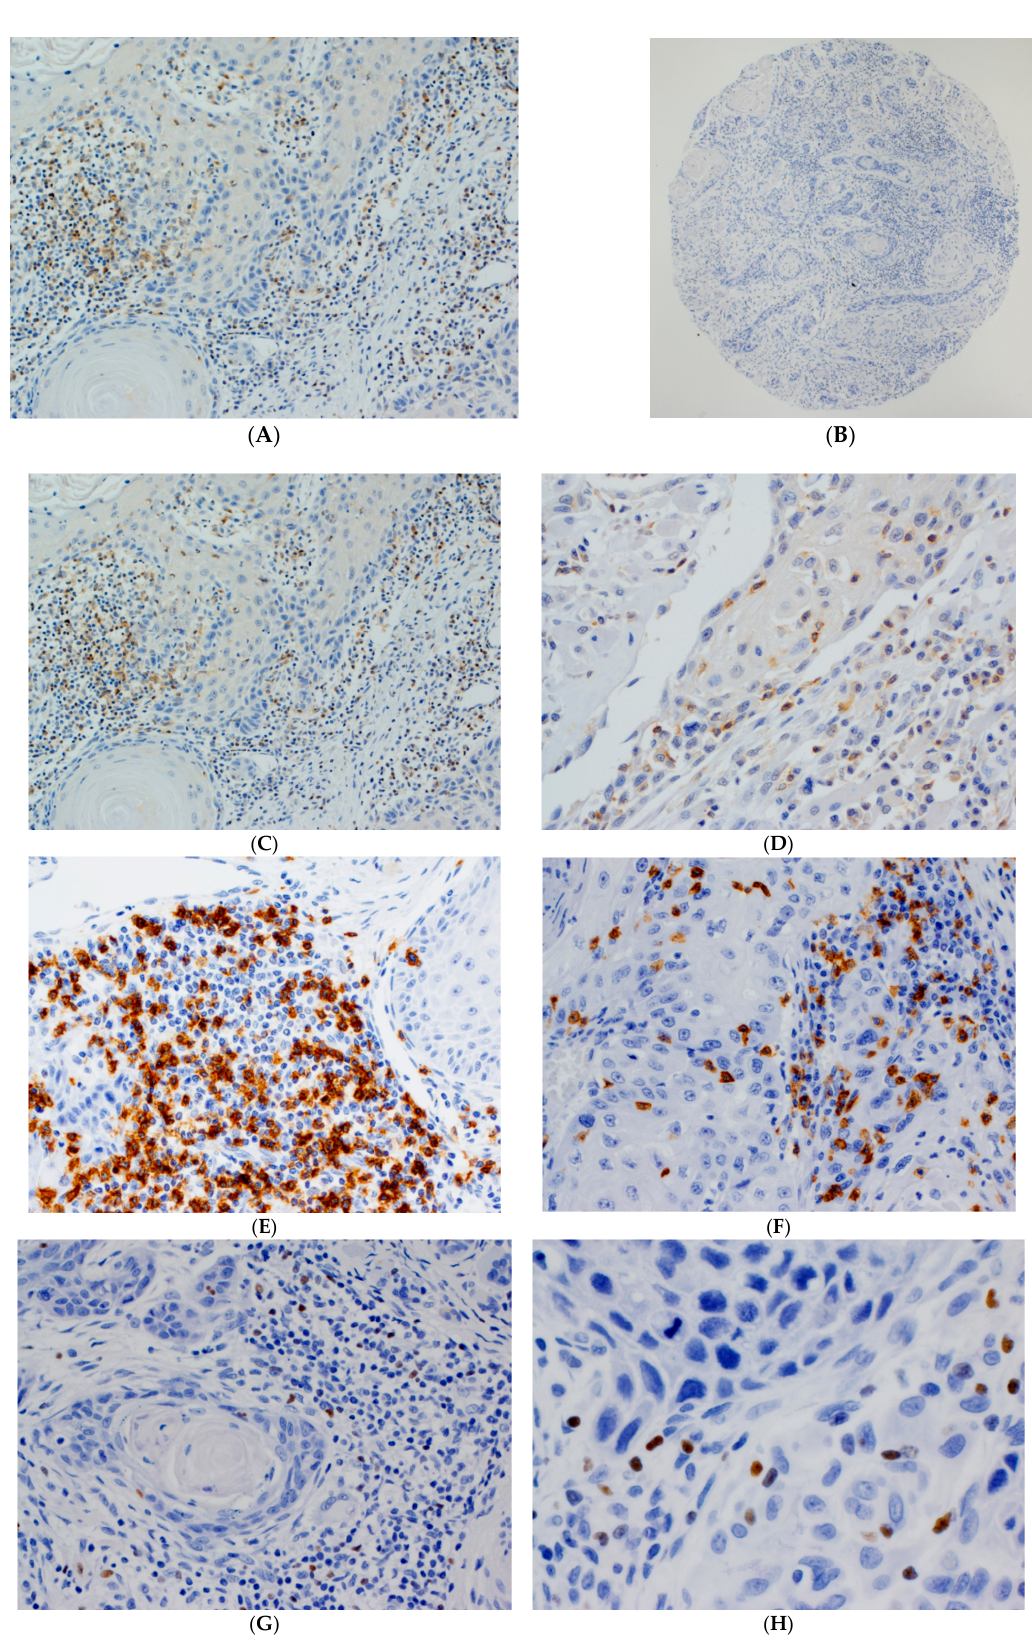
Figure 1. Representative examples of oral squamous cell carcinomas (OSCC) showing high ( A ) and low ( B ) densities of TILs. Stromal and tumoral staining of CD4 + ( C , D ), CD8 + ( E , F ) and FOXP3 + ( G , H ) TILs. Magnification: 50× ( B ); 100× ( A , C , E ); 200× ( D , F , G ); 400× ( H ).